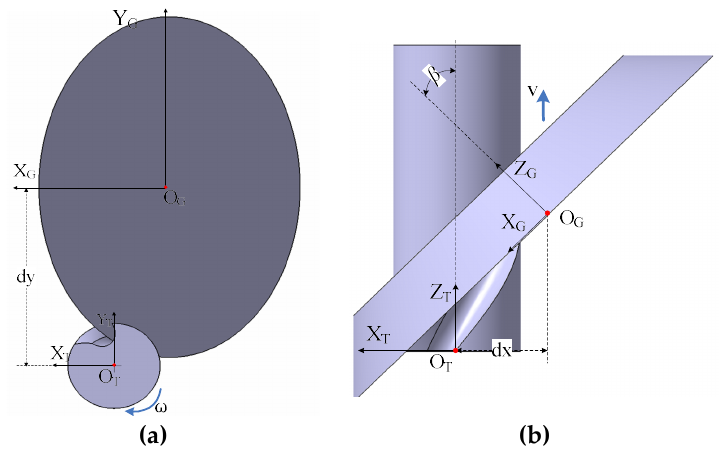
Figure 2. Flute-grinding processes: ( a ) X (cid:2904) Y (cid:2904) view; ( b ) X (cid:2891) Y (cid:2891) view.